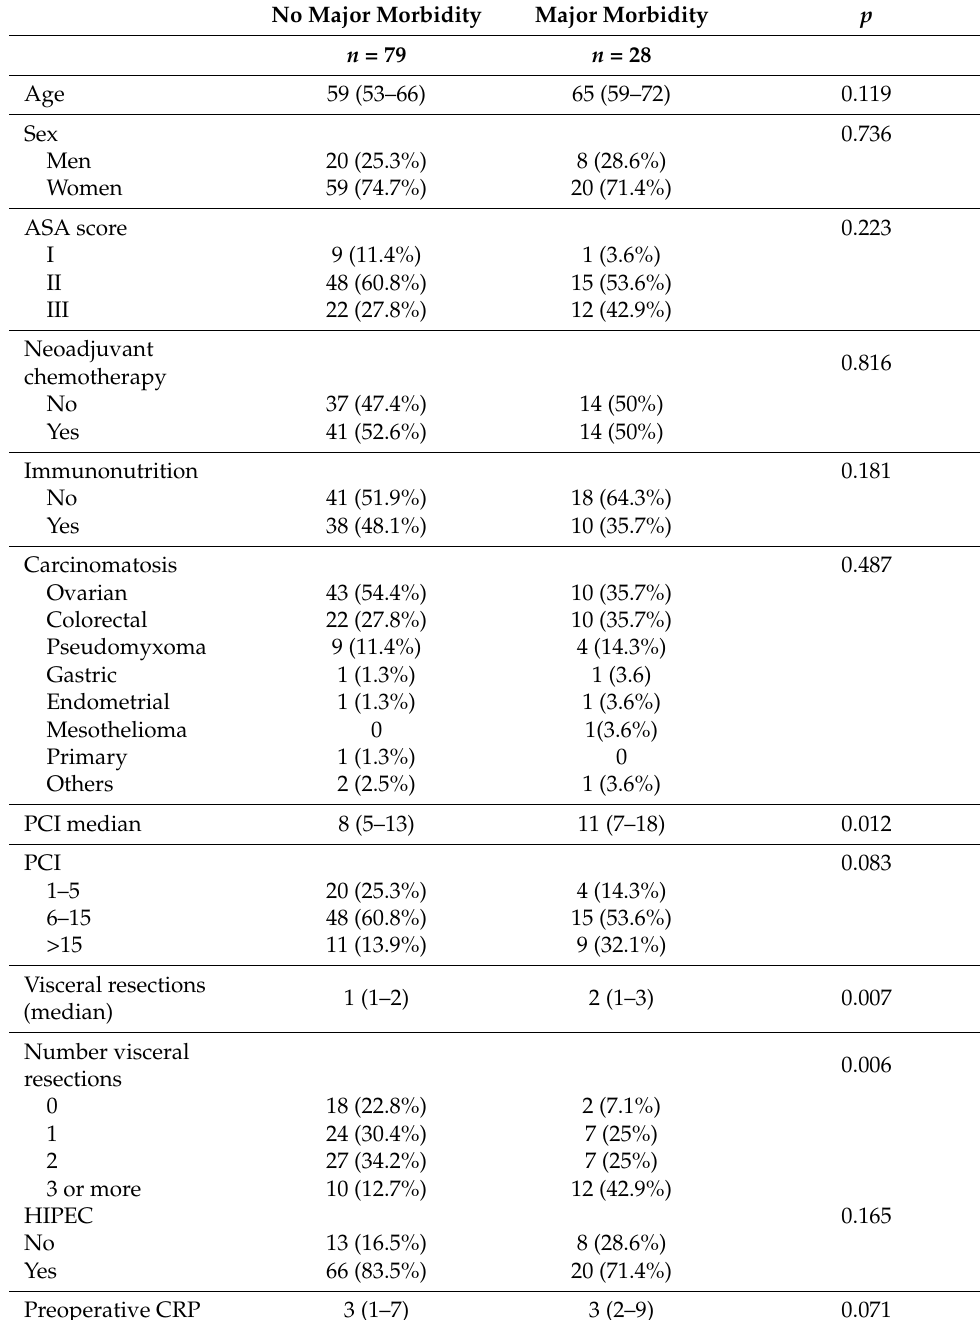
Table 3. Postoperative major